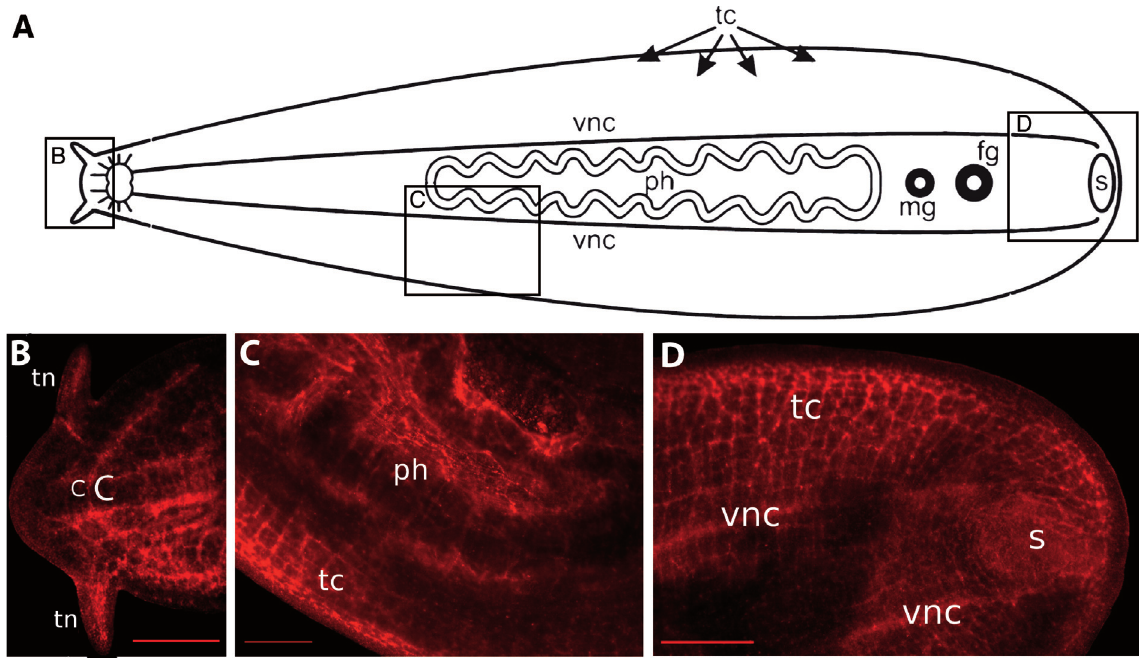
Figure 6 - FMRFamide expressing neurons in Boninia divae (category III). A. Diagram of the nervous system indicates the sites shown in panels B-D. B. In the head, FMRFamide expression is observed in the anterior paired bilateral C-shaped nerve branches and neurons that innervate the tentacles. Notice that no expression is observed in the brain. Scale bar 100 (cid:2) m. C. FMRFamide expression in the pharyngeal plexus and in the submuscular plexus. Scale bar 200 (cid:2) m D. Mesh-like nerves surrounding the sucker also express FMRFamide. Scale bar 100 (cid:2) m. C C-shaped structure, vnc ventral nerve cords, ph pharynx, tc transverse commissures, tn tentacle, s